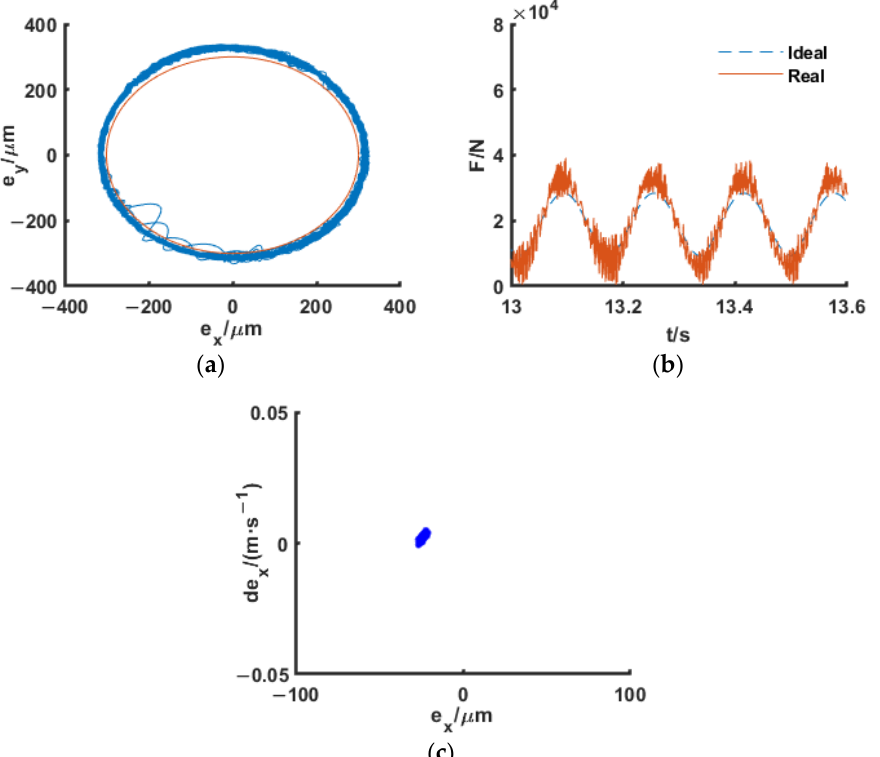
Figure 16. Optimized dynamic characteristic images: ( a ) the axis trajectory of shaft; ( b ) the vibration force applied to the foundation; ( c ) the Poincare mapping.